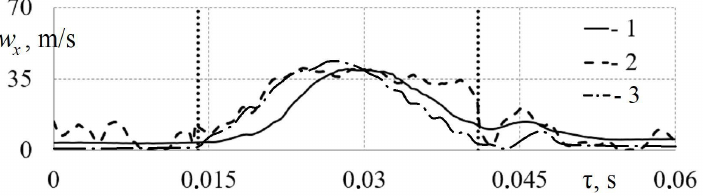
Figure 13. Dependences of the local air flow velocity w x in the intake systems of the engine labora- tory model (1), gasoline RICE (2), and mathematical model (3) on time τ for a crankshaft speed of 1800 rpm and for d = 32 mm. The vertical lines indicate the opening and closing times of the intake valve.